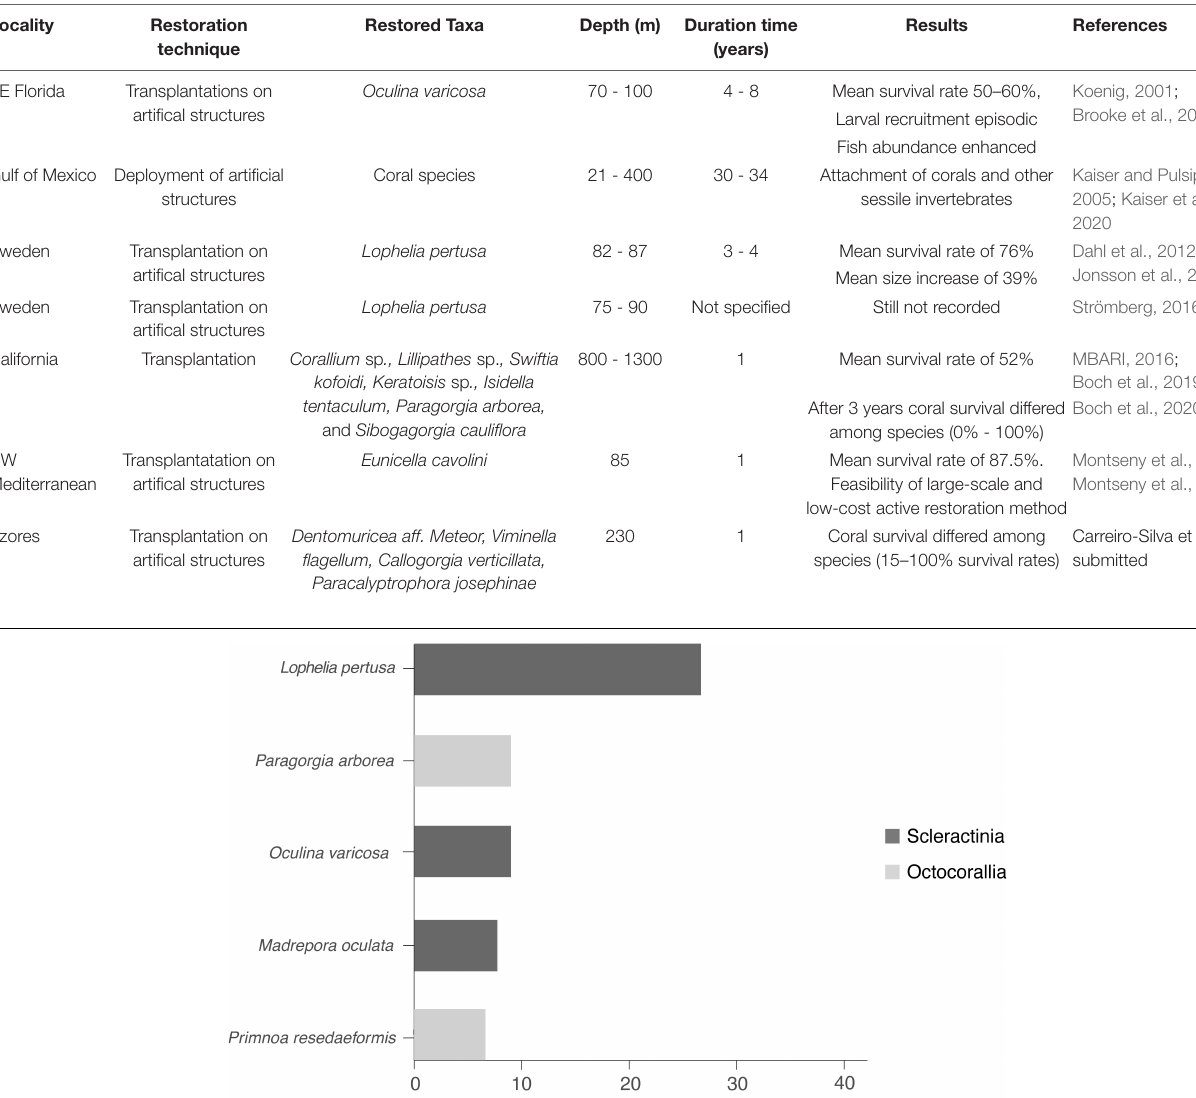
TABLE 1 | Active restoration initiatives carried out to date focused on CWC habitats.